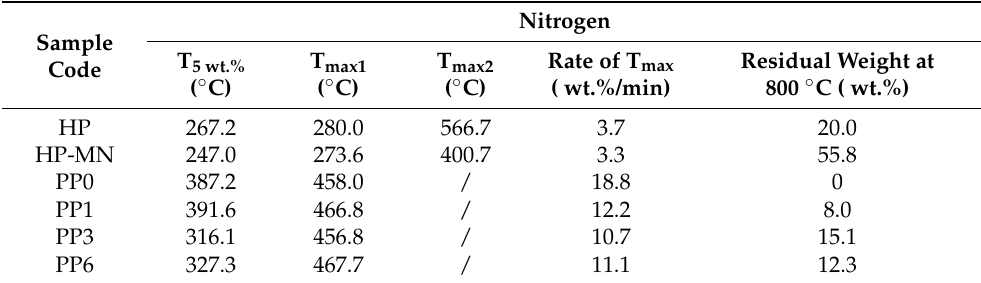
Table 4. TG and DTG curves of HP, HP-Mn, Pure PP and its flame-retardant composites under nitrogen atmosphere.